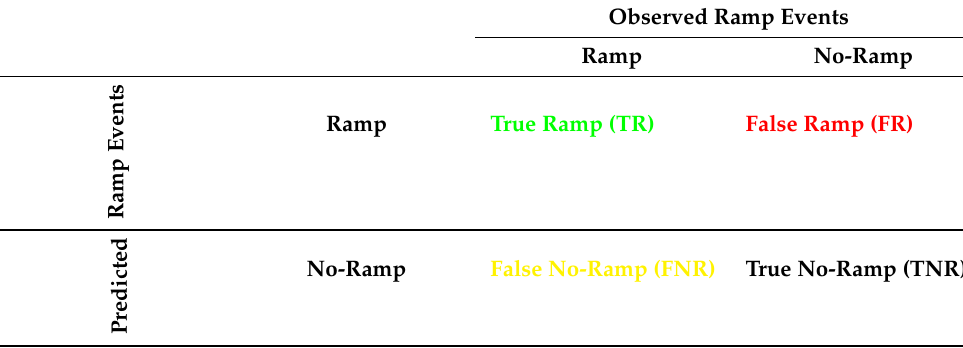
Table 2. Confusion matrix of possible cases of forecasted ramp events.